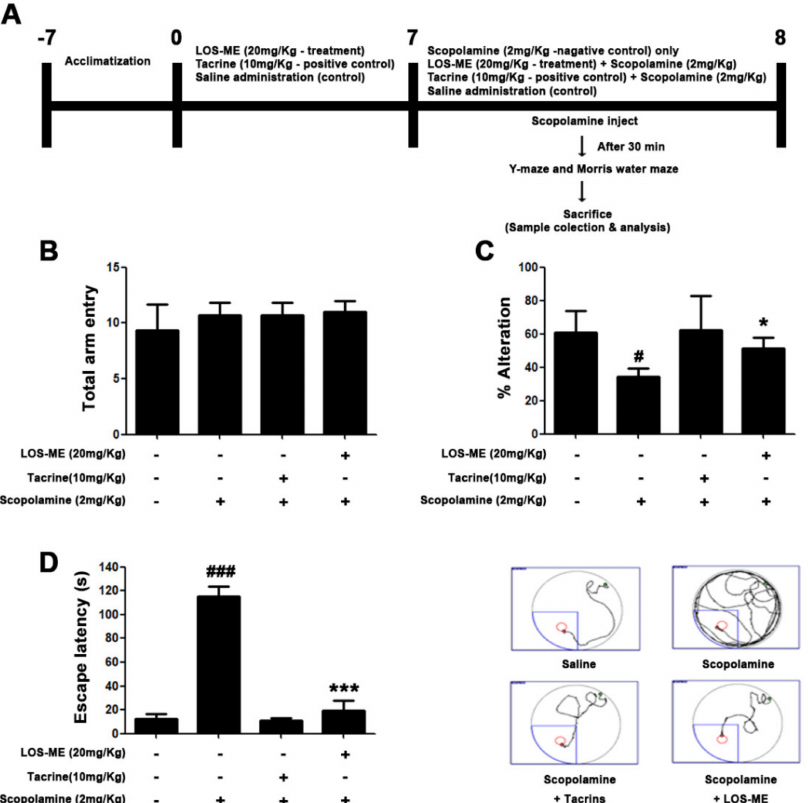
Figure 6. Effects of LOS-ME on cognitive and behavioral impairments in the scopolamine-induced amnesic mouse model. LOS-ME (20 mg/kg, p.o.) was dosed for 7 days, and on the 8th day, scopo- lamine was administered (2 mg/kg, i.p.). ( A ) Schematic representation of the animal experimental design. ( B ) Total number of arm entries in Y-maze task. ( C ) Percentage of spontaneous alterations in Y- maze task. (D ) Escape latency time (s) in Morris water test. Values are mean ± SD, n = 8. Ns (no significant) and # p < 0.05, ### p < 0.001 as compared with control group; * p < 0.05 and *** p < 0.001 as compared with scopolamine-treated group by one-way ANOVA.